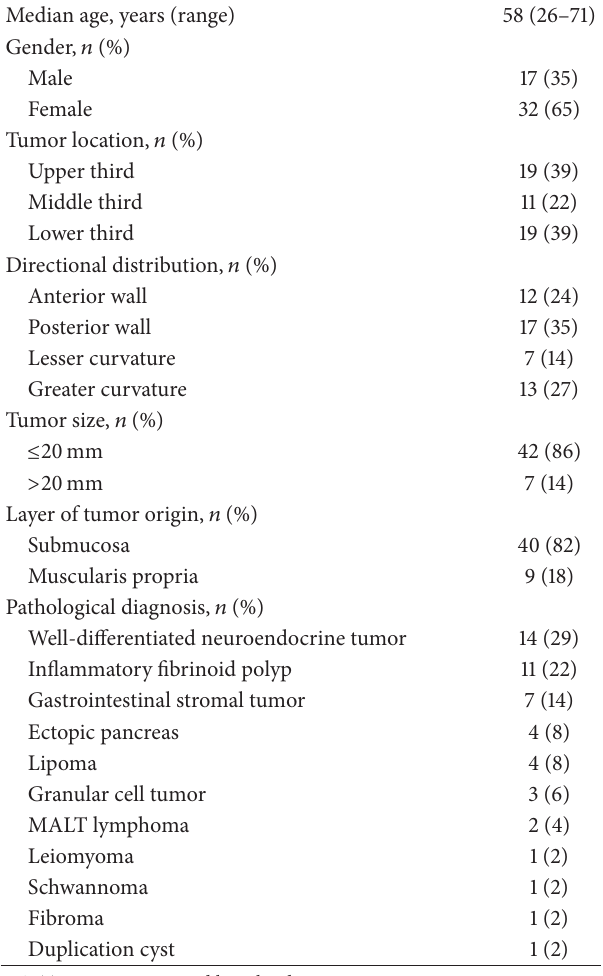
Table 1: Characteristics of the patients and subepithelial